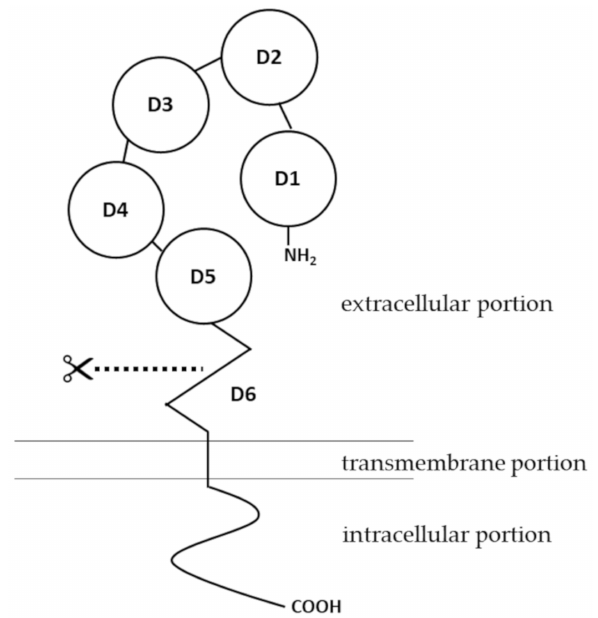
Figure 1. Structure of polymeric immunoglobulin receptor (pIgR). The pIgR contains an intracellular portion, a transmembrane portion and an extracellular portion. The extracellular portion has six domains. Extracellular domains 1 to 5 (D1–D5) are five tandem immunoglobulin-like domains that are involved in binding to Ig polymers. The extracellular domain 6 (D6) contains a site for proteolytic